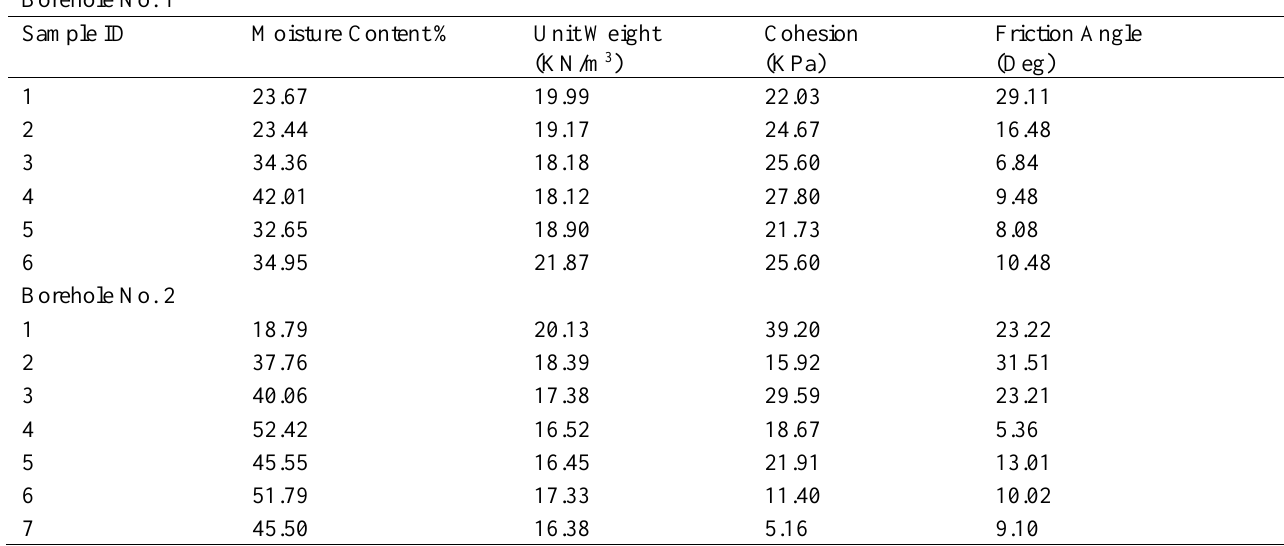
Geotechnical data of soil